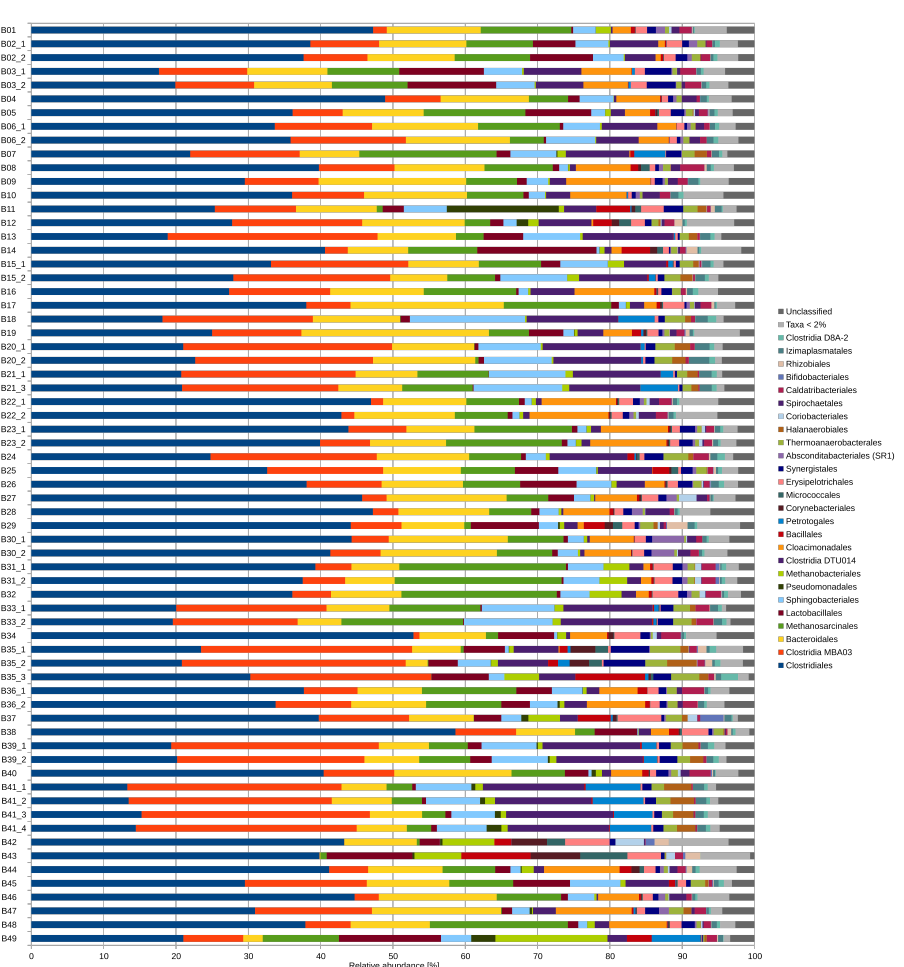
Figure 2. Taxonomic profiles on order level of the 67 analyzed anaerobic digesters from 49 agricultural, full-scale biogas plants as deduced from 16S rRNA gene amplicon data. Orders with a maximal relative abundance less than 1% were summarized. Taxa which were not taxonomically assigned at order level were summarized as